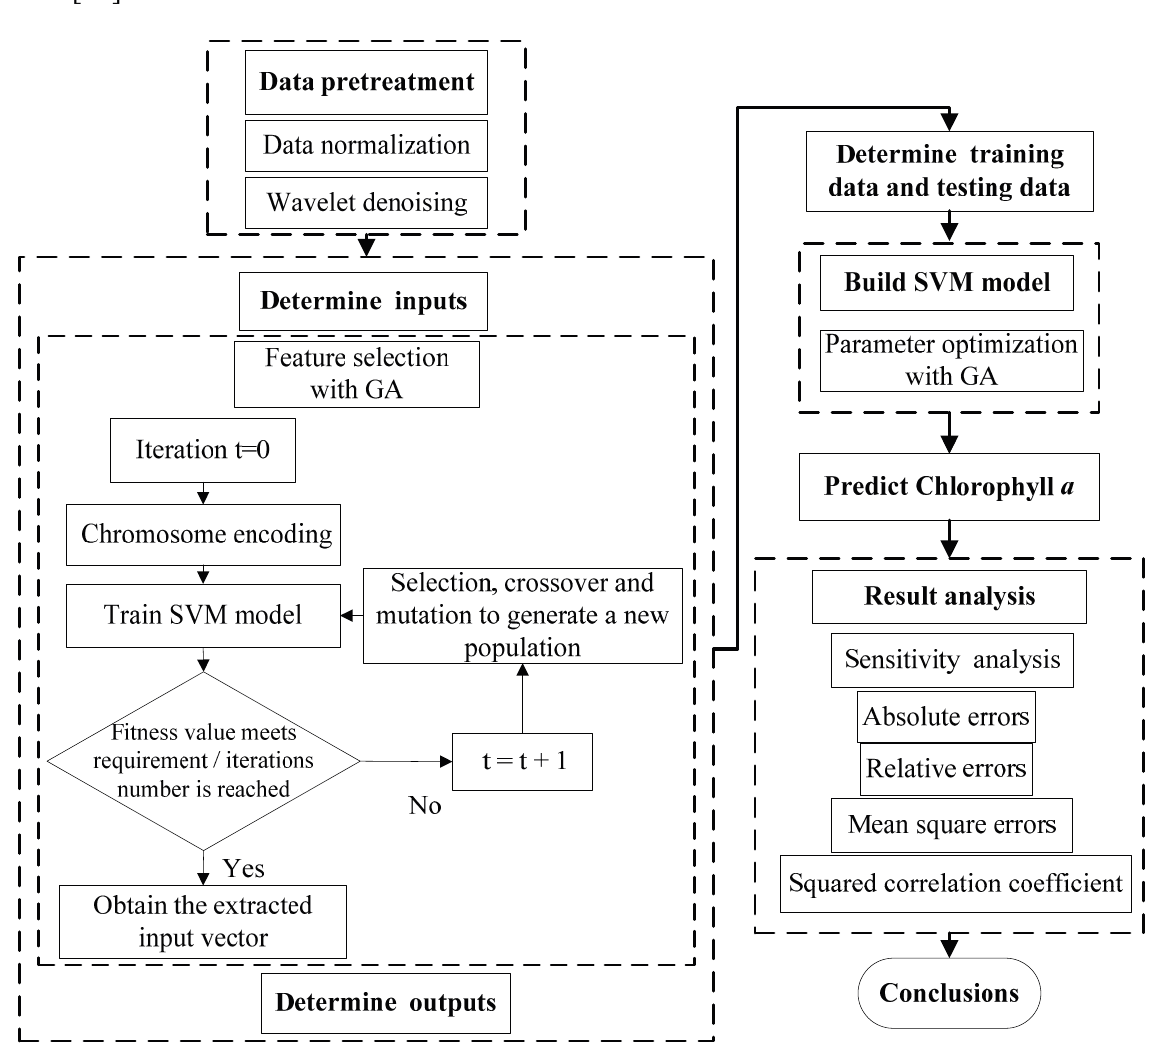
Figure 3. The flow chart for developing simplified structural GA-SVM hybrid model for chlorophyll a